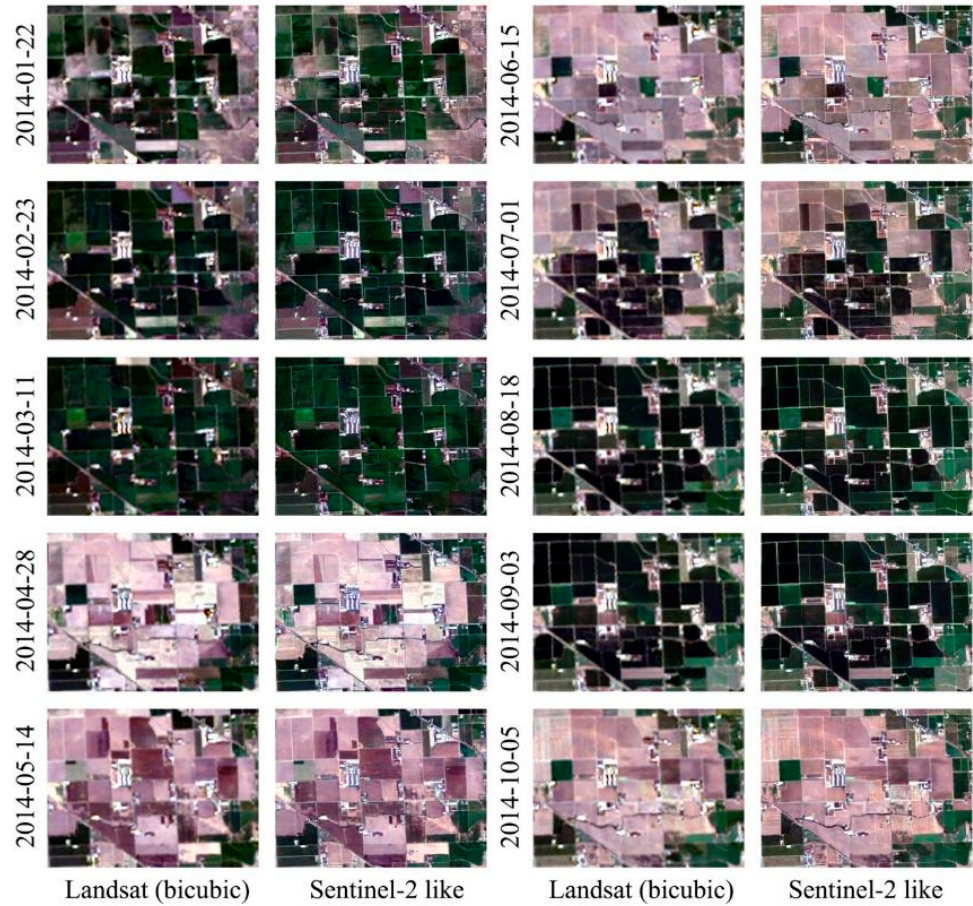
Figure 9. Super-resolution results of time-series Landsat images for capturing cropping rotations over agricultural land in California. From left to right: 10 m interpolation derived from Landsat using the bicubic method, Sentinel-2-like reconstructed image derived from the GAN-based super-resolution.